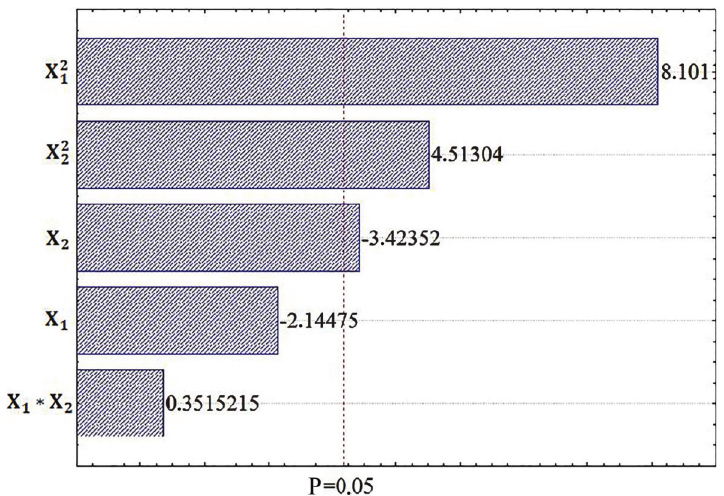
) and temperature 1